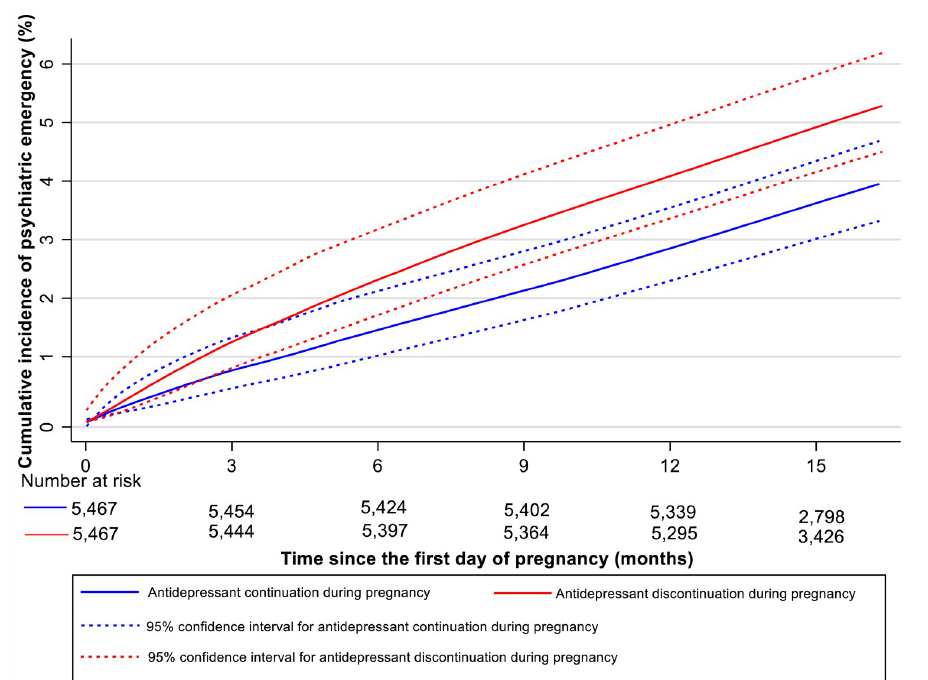
Fig 3. Propensity score–matched smoothed Kaplan–Meier curves for psychiatric emergency since the start of pregnancy among antidepressant discontinuation during pregnancy group versus matched continuation during pregnancy group � . � The cumulative incidence curve is smoothed to avoid personal identification according to the Data Protection Regulation in Denmark.